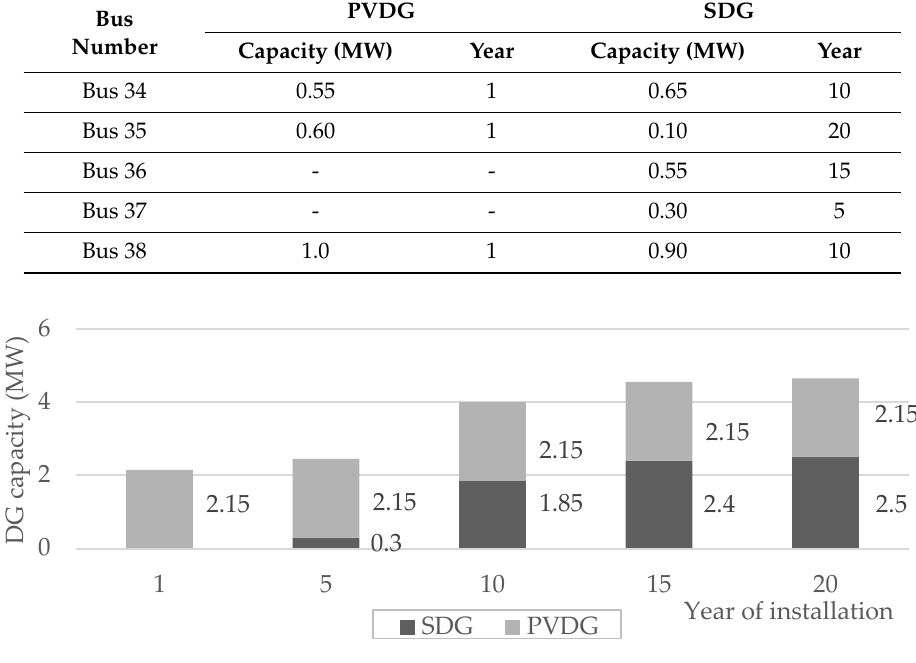
Figure 5. Comparison of the annual energy cost bought from the grid through the planning period. 7.4. Cost of Line Upgrades The NPW of line upgrades for CASE-A is $7.589M, while for CASE-B it is $5.763M, corresponding to a reduction of 24.06%, shown in detail in Figure 6. This reduction is due to the deferral of required line upgrades to meet the load growth by installing DG units, which reduces the consumed current from the grid and consequently the current passing in the system lines. 7.5. Cost of Protection System Upgrades In CASE-A , the NPW for protection upgrades is $0.53M. These upgrades are due to the load growth and are distributed over the 20-year period.